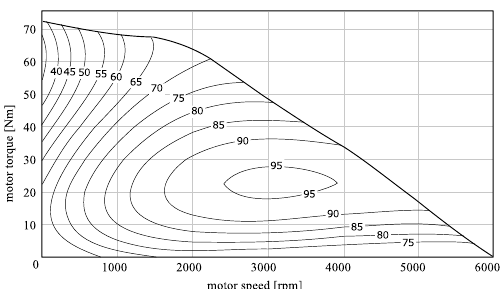
Figure 4. Electric motor characteristic curve and efficiency